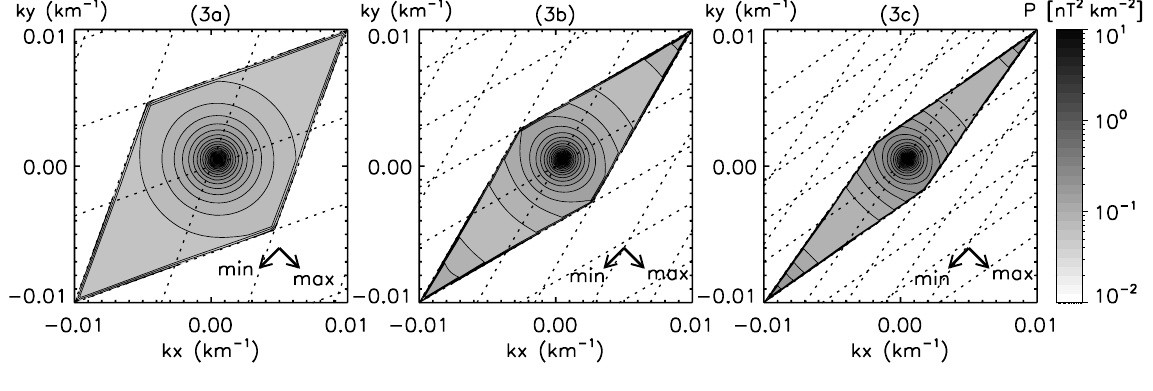
Fig. 8. Aliased spectra for different diamond-shaped Brillouin zones, with the angle between the two reciprocal vectors 50 ◦ (left), 30 ◦ (middle), and 20 ◦